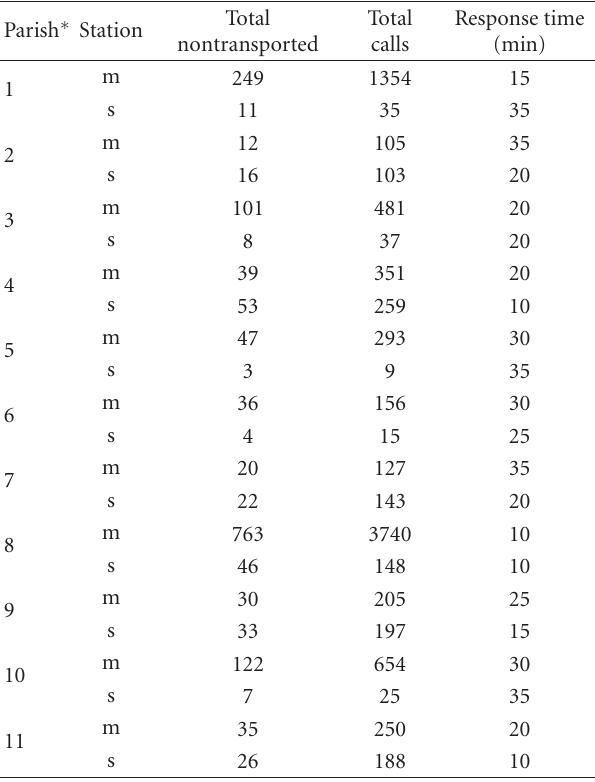
Table 2: Number of calls from each parish. Parish ∗ Station